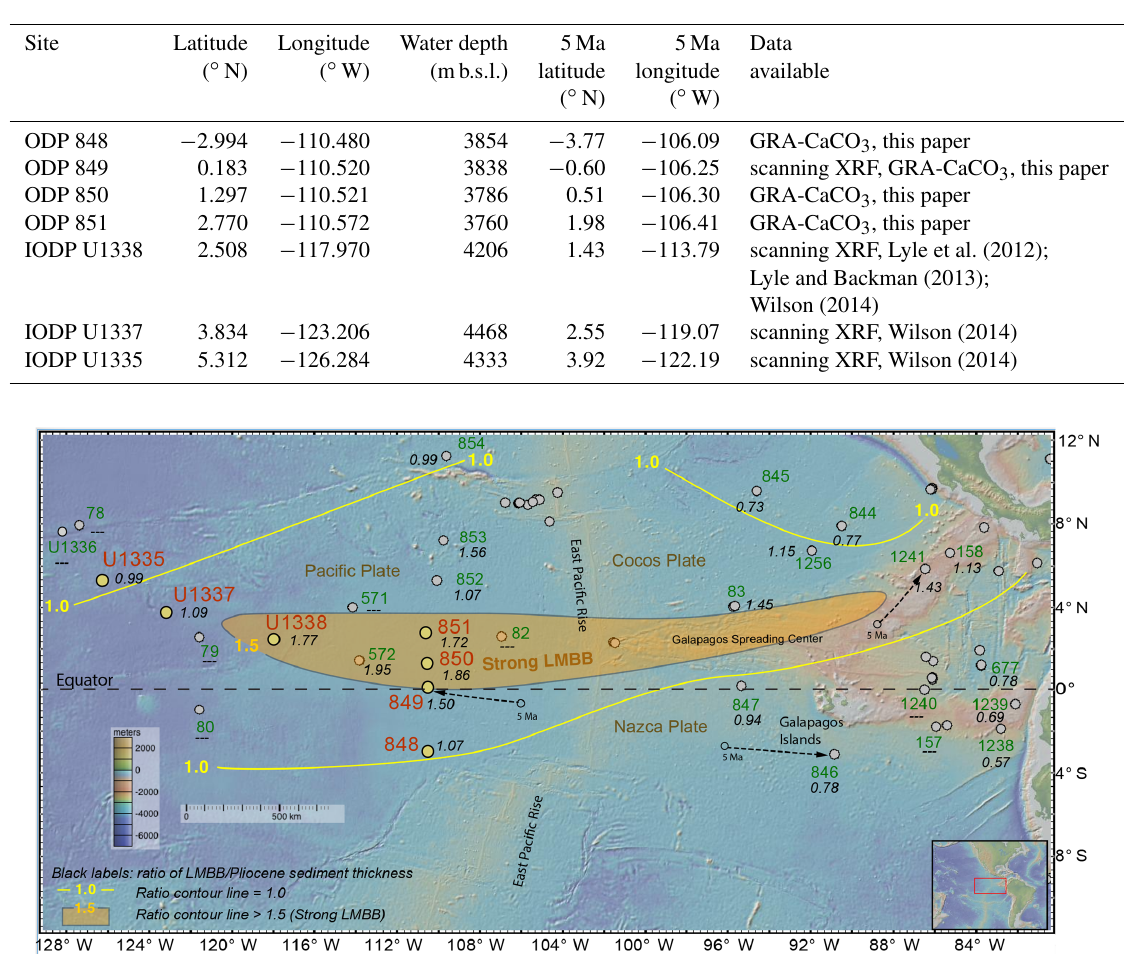
Figure 1. Overview of east Pacific drill sites. Figure made with GeoMapApp (http://www.geomapapp.org, last access: 1 October 2018) (Ryan et al., 2009). Gray dots indicate positions of DSDP or ODP drill sites. Red site labels: ODP and IODP drill sites from the eastern equatorial Pacific used in this paper with other DSDP, ODP, or IODP sites labeled in green. All sites are at their modern locations. Example backtracked positions at 5 Ma are shown for site 849 on the Pacific Plate (representative for sites U1335, U1337, U1338, and sites 848– 854), site 846 on the Nazca Plate (representative for sites 847, 1238, and 1239), and site 1241 on the Cocos Plate (representative for sites 844, 845, and 1256), assuming a hotspot reference frame. Thickness of the 8–4.5Ma sediment divided by the 4.5–0Ma sediment thickness (LMBB / Pliocene ratio) are indicated by the italic black labels at each drill site. Sites on crust younger than 8Ma, or where the section was incompletely drilled, or with a hiatus in the interval are marked with “—”. Yellow lines mark where the LMBB / Pliocene ratio is 1, while the shaded orange region is where the ratio is >1.5, marking the major LMBB locus of deposition. Thickest LMBB sequences are found on sites with crust older than 8Ma on the Pacific and Cocos plates just north of the Equator. Sites south of the Equator in the easternmost Pacific have thicker sediments in the 4.5–0Ma time range, indicating high and young sedimentation